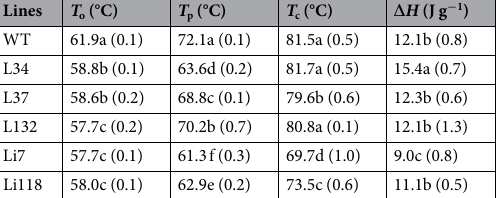
Table 2. DSC analysis of starch from the transgenic plants and WT a . a Data are presented as the mean of three replicates with standard deviation given in the parenthesis. The values in the same column with different letters differ significantly at P < 0.05, based on Student’s t -test.